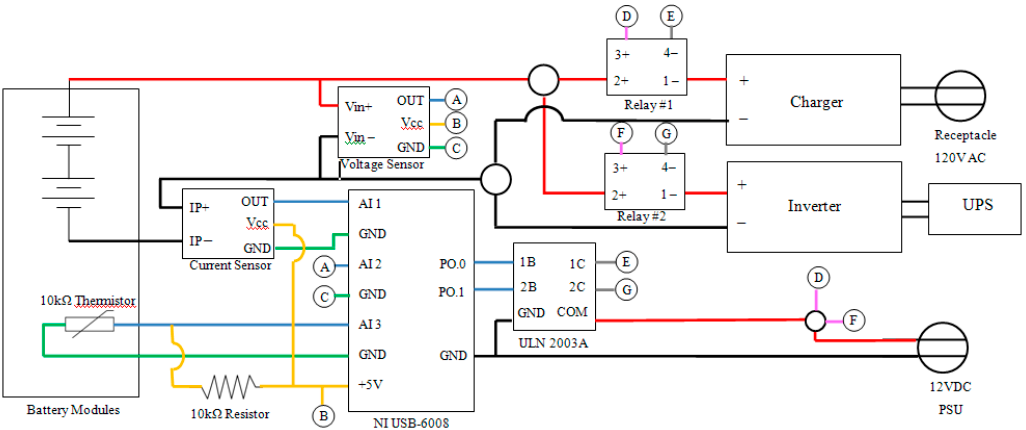
Figure 8. Electrical schematic of a re-purposed battery pack system.